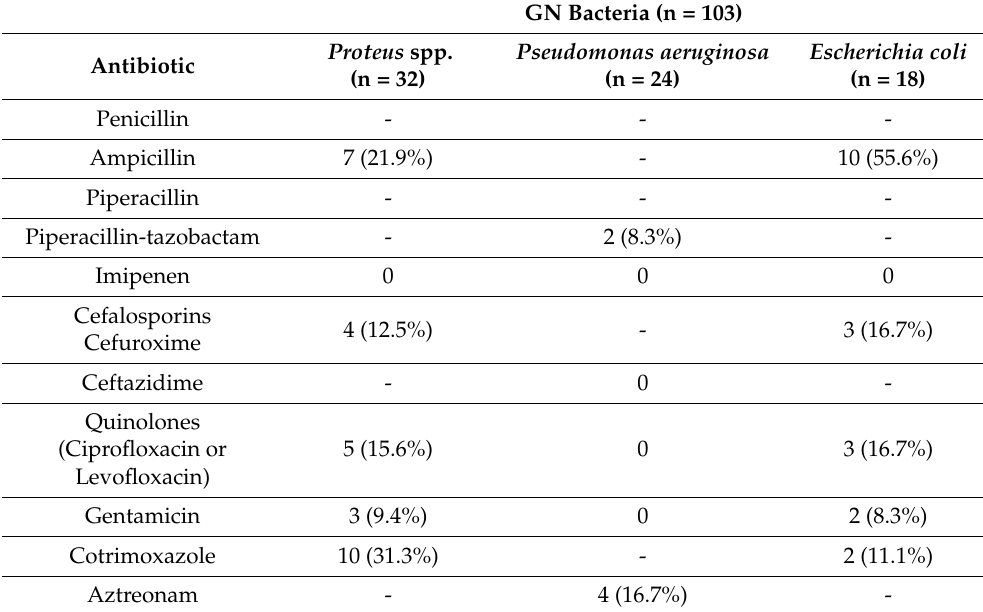
Table 4. Resistance analysis of common GN bacteria to sensitive antibiotics.